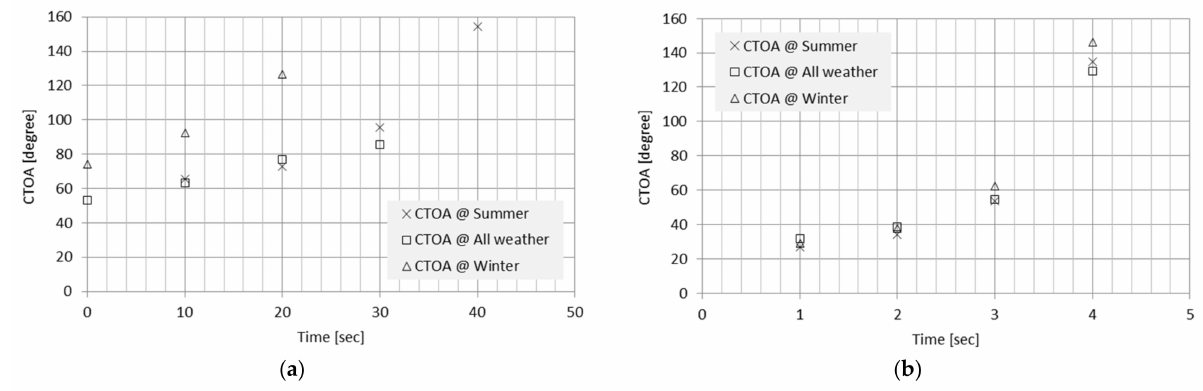
Figure 10. CTOA(Y)–time(X) curves: ( a ) CTOA(Y)–time(X) curves at 5 mm/min; ( b ) CTOA(Y)– time(X) curves at 50